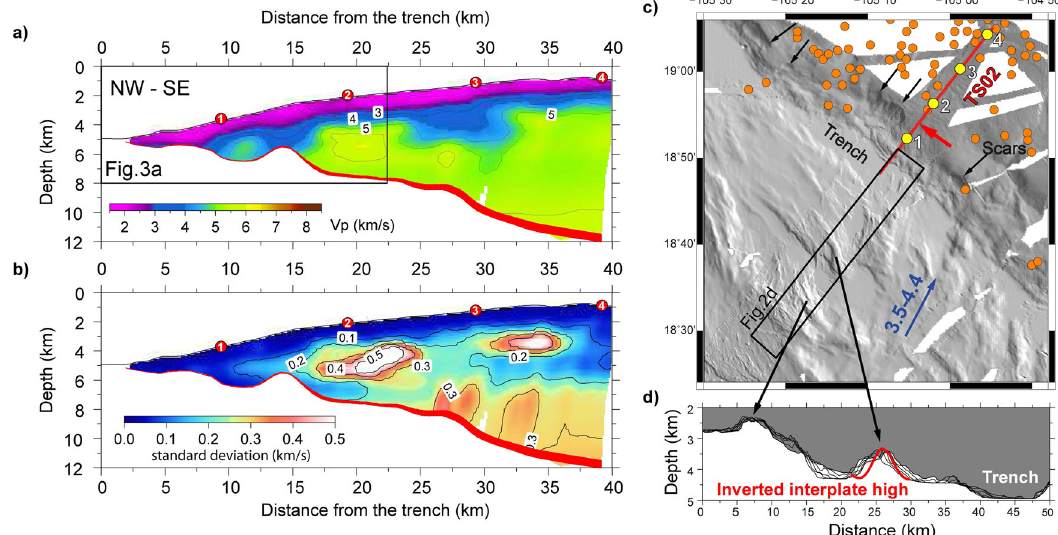
Fig. 2 Upper-plate tomographic model, and the relation between interplate morphology and incoming oceanic fabric. a Average P-wave velocity model of the 500 Monte Carlo inversions, and average interplate geometry with error bounds (red band). Red dots are ocean-bottom seismometers. b Standard deviation model of velocities associated with the Monte Carlo analysis. The red band is the same average interplate geometry with error bounds as in ( a ). c Close-up of the margin showing the location of line TS02 and the presence of margin scars (black arrows), indicating past slope failure events. The red arrow indicates the position of the interplate high retrieved at 15 km along our model ( a ). Orange dots depict aftershocks of the 1995 Colima-Jalisco earthquake from ref. 19 . d Along-dip topographic pro fi les of the outer rise extracted from the black box in ( c ) compared with the inverted interplate high (red line). Black arrows show the location of oceanic ridges on the outer